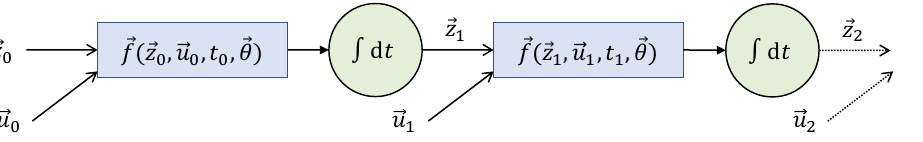
Figure 1. NODEs with external variables; (cid:126) z t represents the state variables at time t and (cid:126) u t represents the respective external variables. Adapted from Figure 1 in [17], which is licensed under CC BY 4.0 (https://creativecommons.org/licenses/by/4.0/, accessed on 23 February